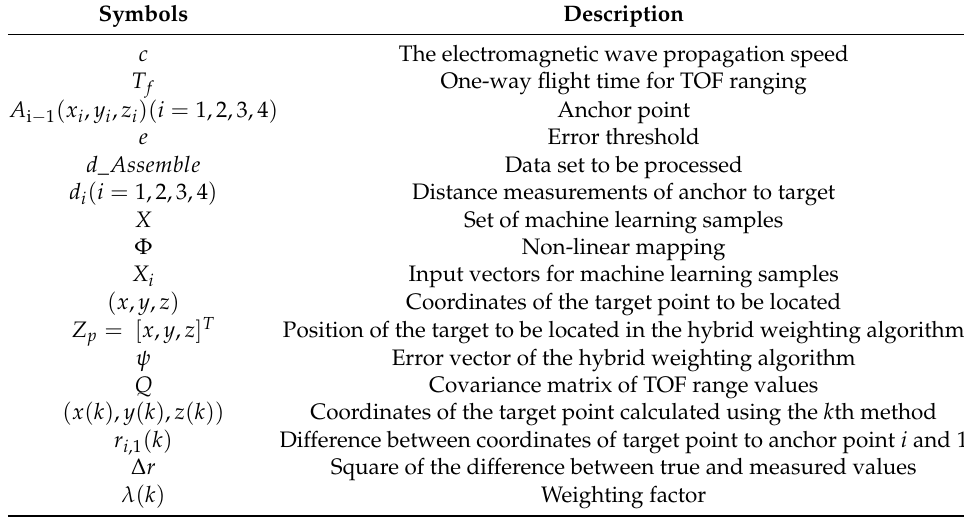
Table 1. Main symbols used in this